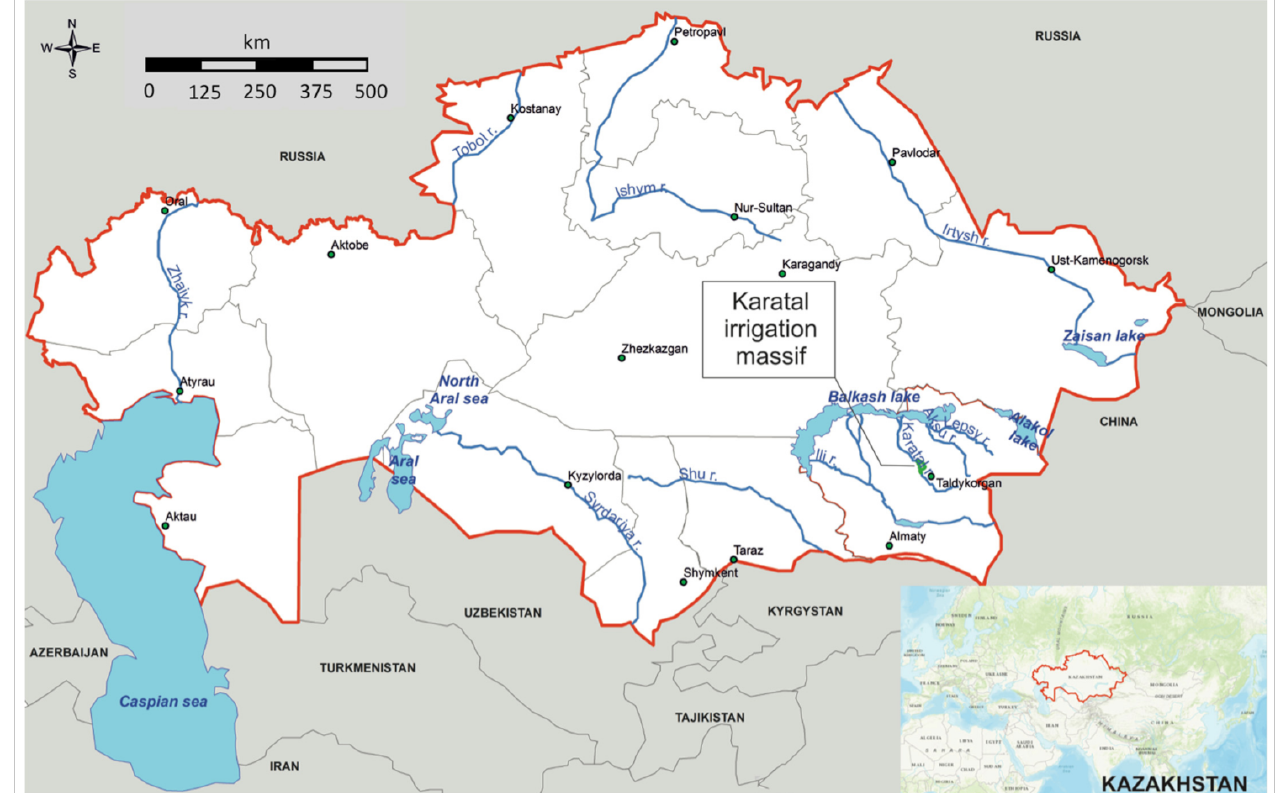
Figure 1. Location of the Karatal irrigation massif inside the Republic of